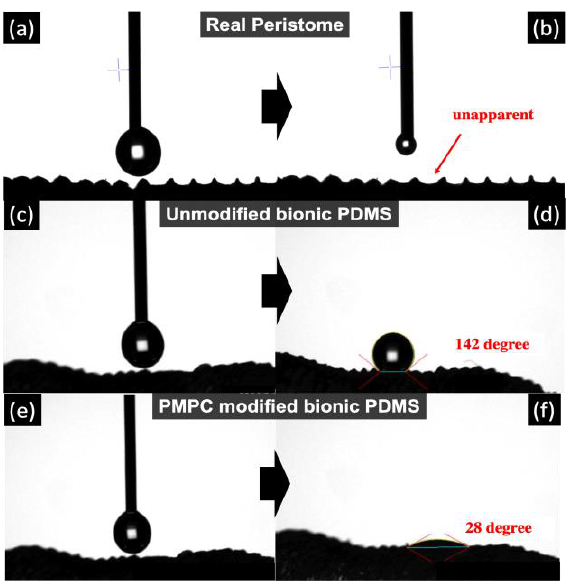
Figure 7. The contact angle of ( a , b ) the pristine Nepenthes peristome (almost 0°), ( c , d ) Nepenthes peristome-like structure replicated by PDMS without MPC modification, and ( e , f ) the Nepenthes peristome-like structure replicated by PDMS with MPC modification.